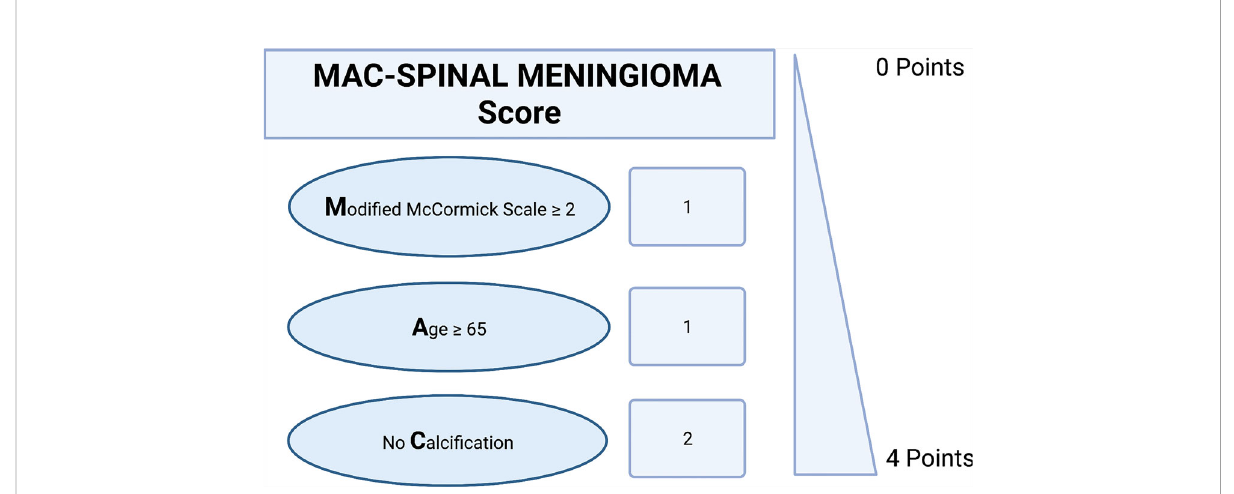
FIGURE 4 A proposal for a novel clinical scoring sheet to preoperatively estimate the risk of an increased MIB-1 labeling index ( ≥ 5%). An additive score of ≥ 3 points implies a probability of 81.3% for having an increased proliferative